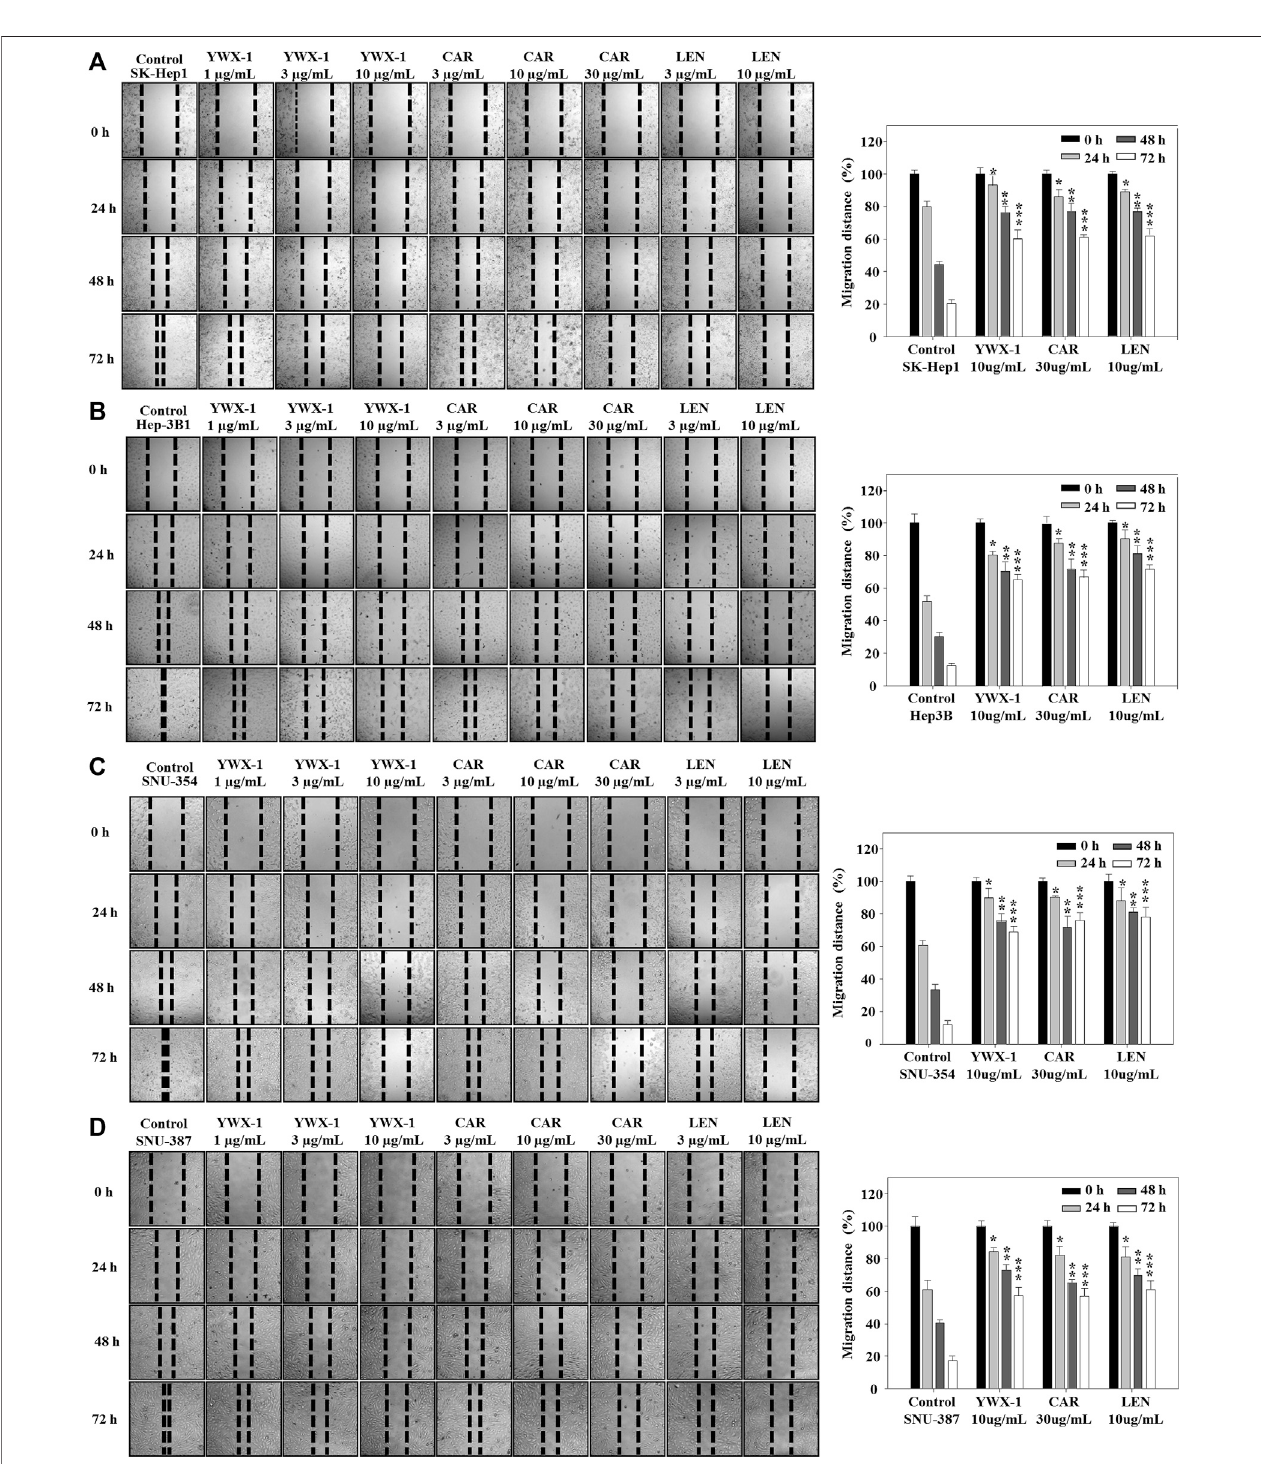
FIGURE 4 | Carrimycin (CAR) and monomeric isovalerylspiramycin I (YWX-1) suppress the migration of hepatocellular carcinoma cells. (A – D) SK-Hep1, Hep3B, SNU-354, and SNU-387 cells were treated with different concentrations of carrimycin and monomeric isovalerylspiramycin I. Migration was observed by an optical microscope( × 200magni fi cation).Statisticallysigni fi cantdifferencesareindicatedwhencomparedwithcontrolgroup.Datarepresentedasmean ± standarddeviationof three independent experiments (n (cid:2) 3).